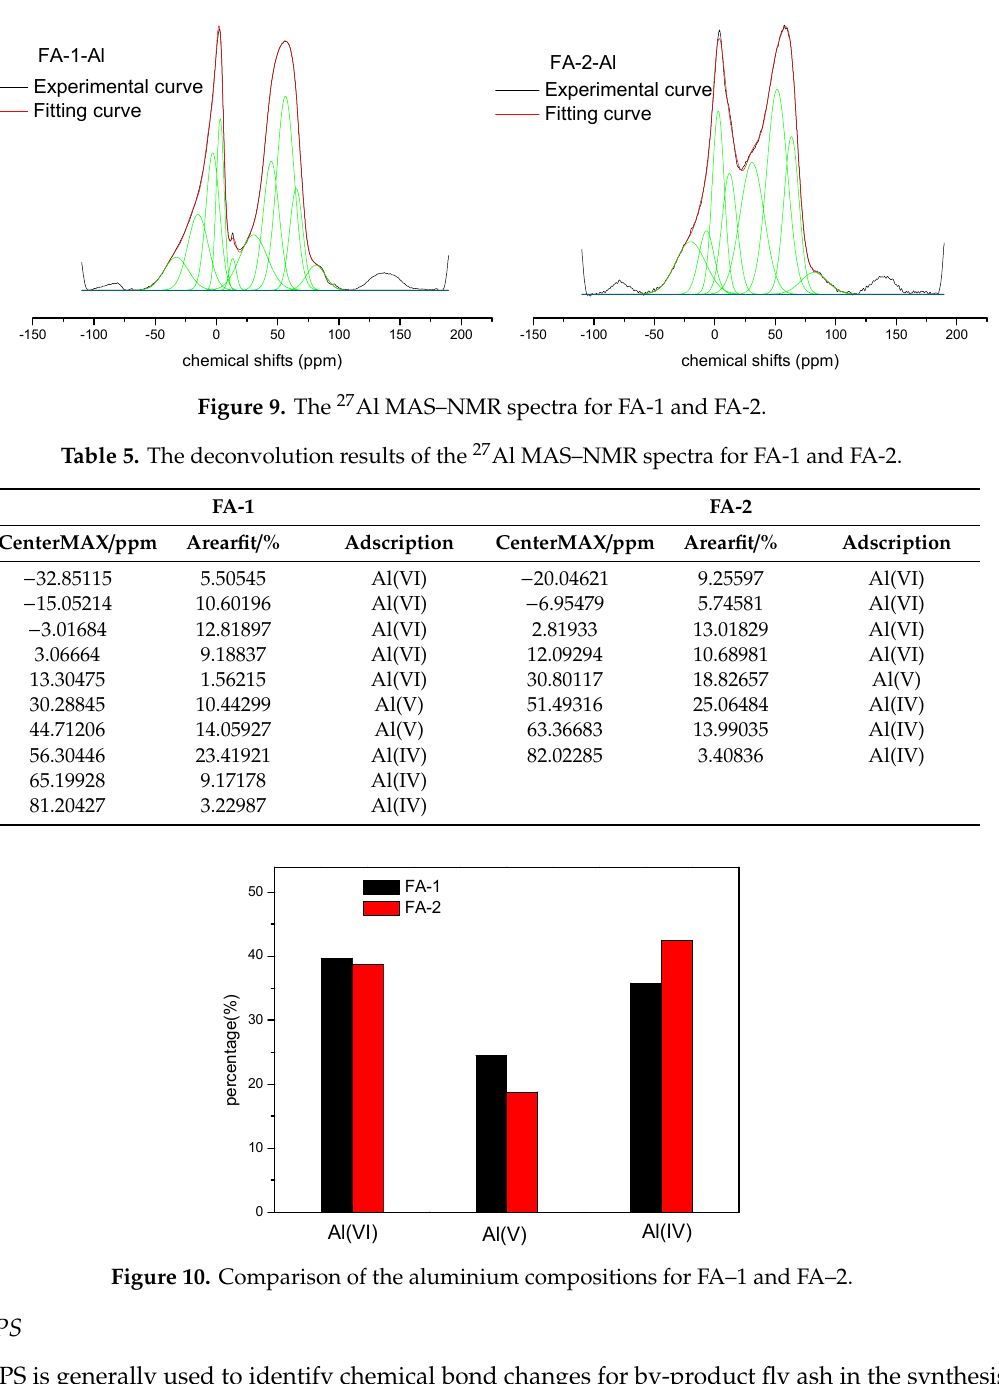
Figure 10. Comparison of the aluminium compositions for FA–1 and FA–2.